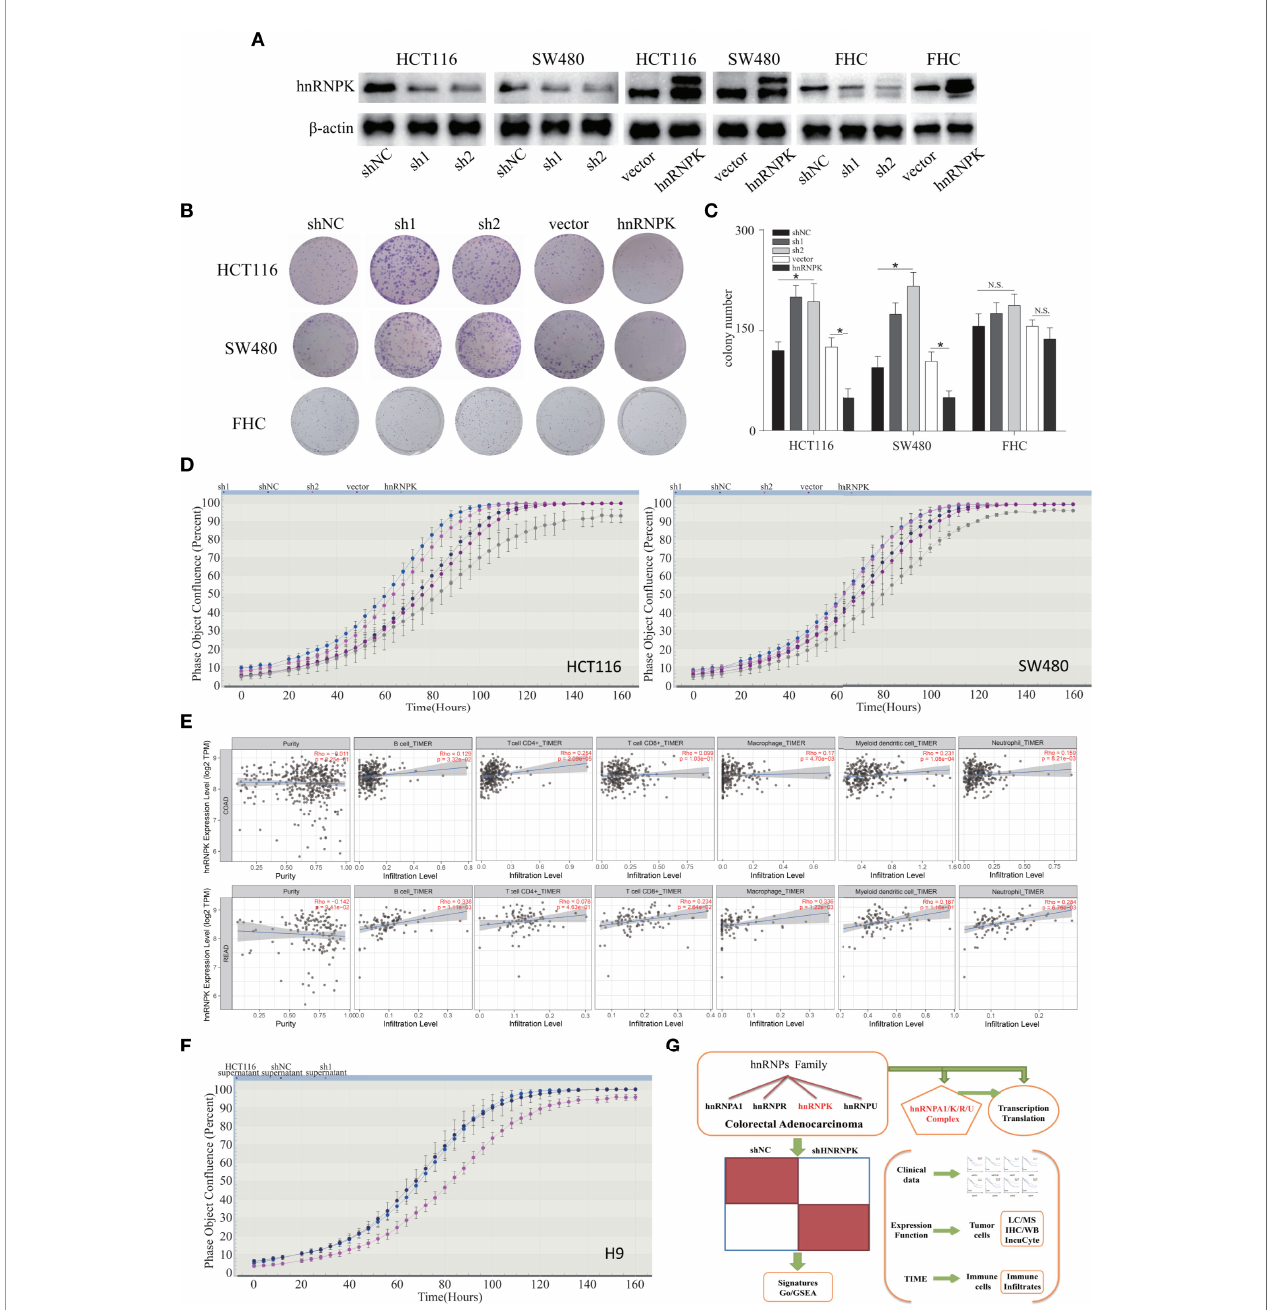
FIGURE 8 | HnRNPK was a favorable factor in human colorectal adenocarcinoma, promoting immune cell in fi ltration and inhibiting tumor growth. (A) Stable hnRNPK-knockdown and hnRNPK-overexpressed cell lines (HCT116, SW480, and FHC) were established by lentiviral infection. WB revealed that the expression of hnRNPK was downregulated or upregulated in a stable manner. (B, C) In HCT116 and SW480 cells, the data showed that the cell clonogenicity was promoted after hnRNPK knockdown and attenuated after hnRNPK overexpression. In FHC cells, we found that hnRNPK knockdown or overexpression did not affect the cell clonogenicity. (D) IncuCyte-based analysis was used to accurately monitor the cell proliferation. The data revealed that cell proliferation was increased after hnRNPK knockdown and attenuated after hnRNPK overexpression. (E) The relationship between hnRNPK expression and in fi ltration of six immune cell types was analyzed to estimate the effect of hnRNPK on the colorectal adenocarcinoma microenvironment. A signi fi cantly positive correlation was observed between hnRNPK overexpression and in fi ltration of the B cells, CD4+ T cells, macrophages and neutrophil cells. (F) After treatment with supernatant of hnRNPK-knockdown cells, the cell proliferation of H9 was inhibited. (G) Proposed model for the role of hnRNPK/A1/R/U complex in human colorectal adenocarcinoma. * P <